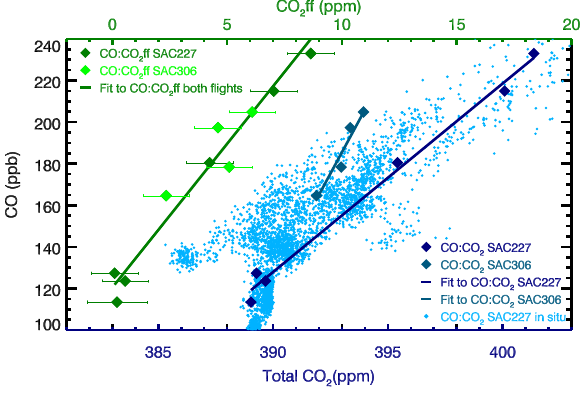
Fig. 3. CO:CO 2 ff emission ratios. Gray bars: inventory based emis- sion ratios, from CO and CO 2 ff inventories. CO inventories are from the USEPA NEI database for 2002 and 2005 and California Air Resources Board CEPAM database for 2009. The emission ra- tio is calculated from each CO inventory using two CO 2 ff invento- ries (Vulcan and CEPAM), extrapolated to the same year as the CO inventory. Error bars are derived from the difference between the two CO 2 ff inventories. Green: R CO / CO from this study. Blue: 2 ff R CO / CO from this study (using total CO 2 rather than CO 2 ff). Pur- 2 ple: direct on-road tailpipe emission measurements from Bishop and Stedman